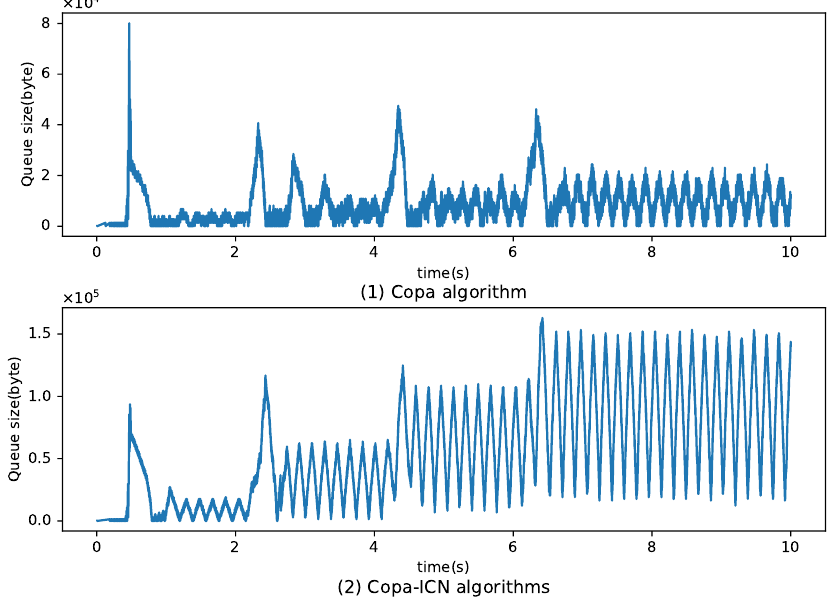
Figure 11. The bottleneck buffer queue of the transmission process started at 4 different times over